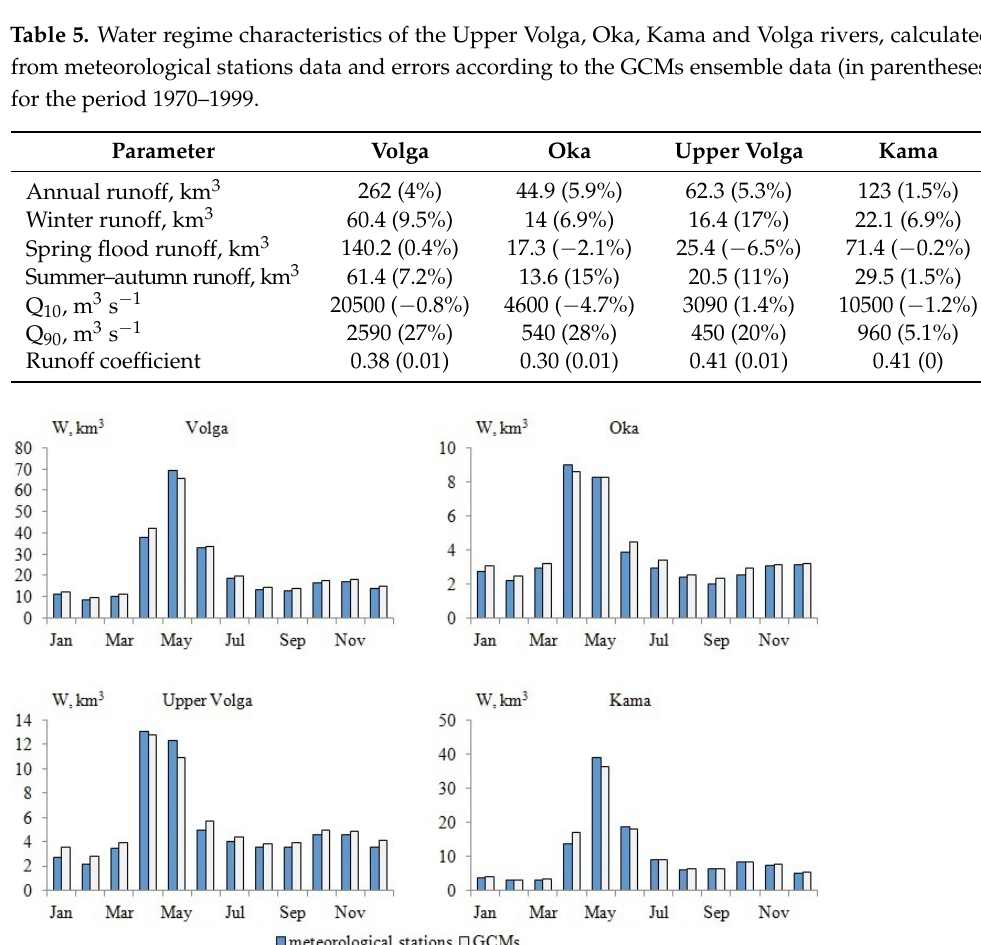
Figure 4. Mean monthly runoff of the Volga, Oka, Upper Volga and Kama rivers calculated using a hydrological model based on GCMs ensemble and meteorological stations data for the period 1970–1999.